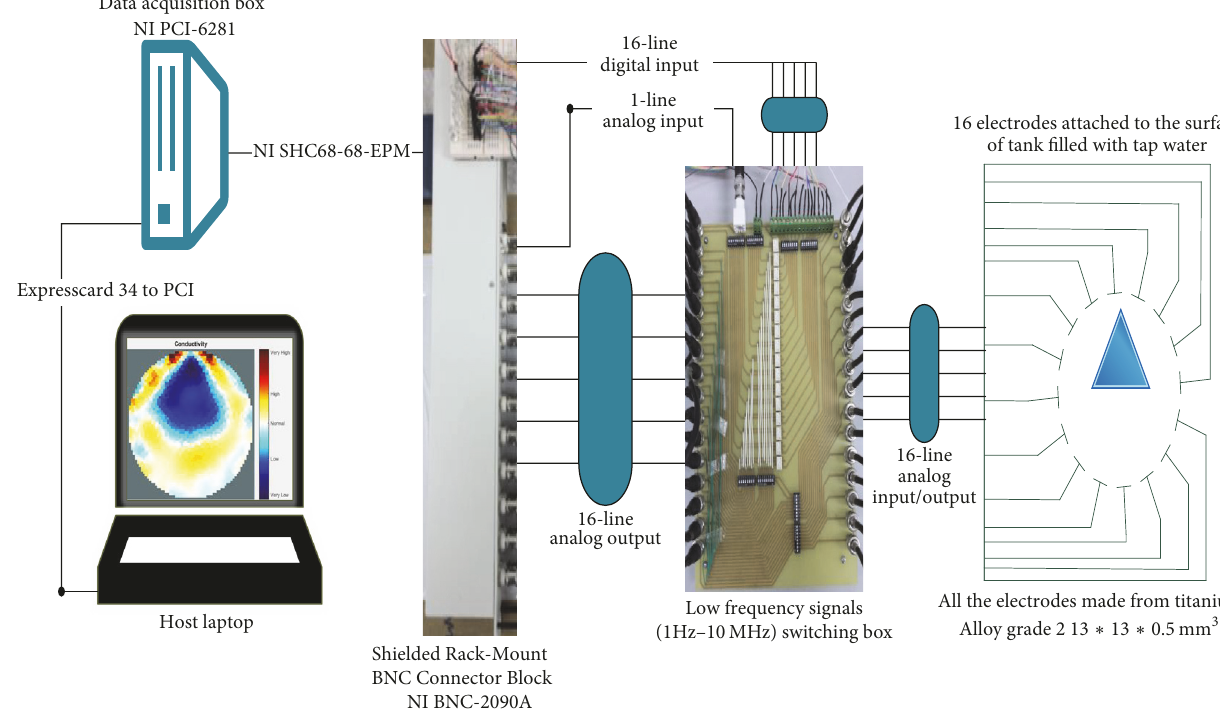
Figure 1: The current structure of the UNMC EIT